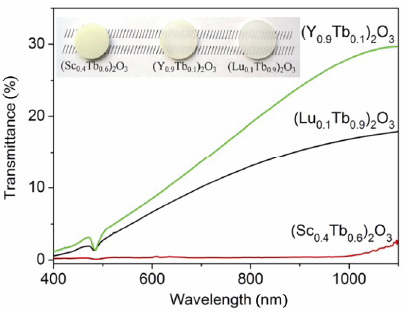
Fig. 6 Transmission spectrum and appearance